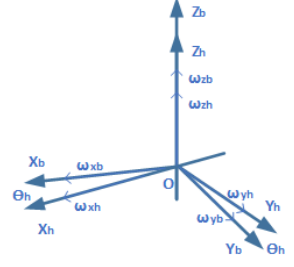
Figure 2. Relation between carrier coordinate with heading coordinate